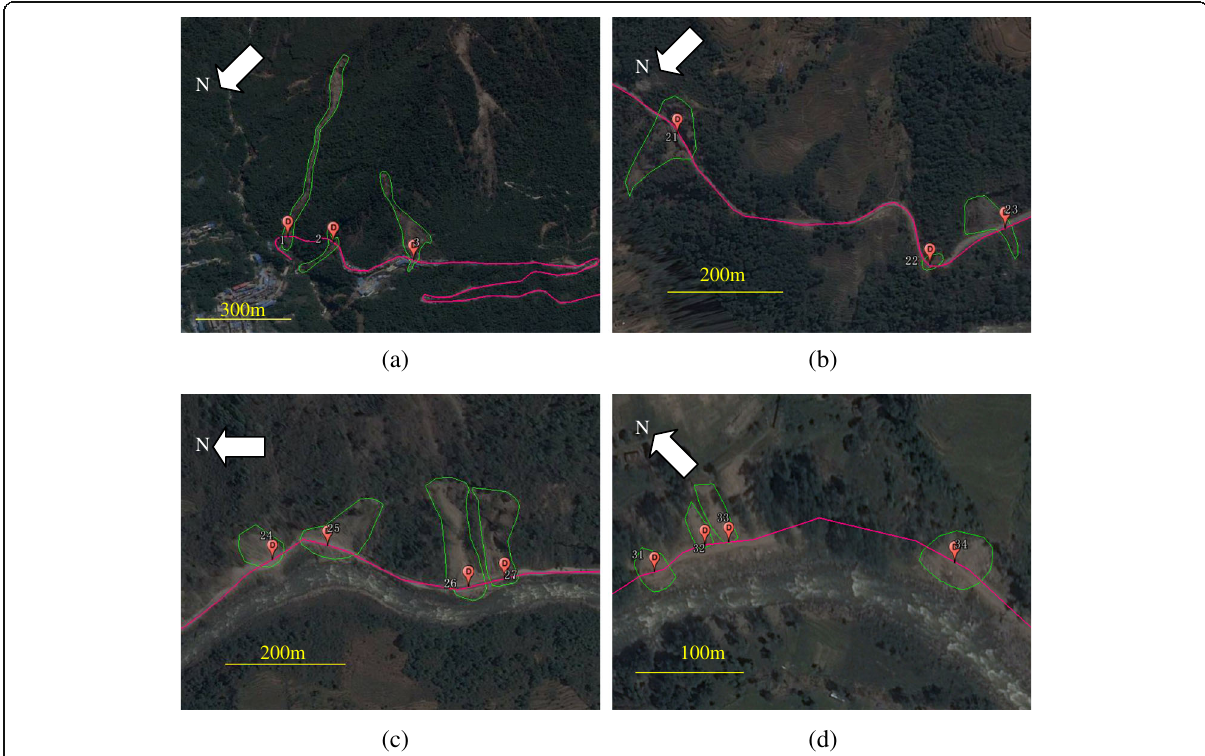
Fig. 7 Damaged sites along Araniko Highway by coseismic landslides have been seen on satellite images. The detailed information of the landslides and associated damages on the road is listed in Table 1. a the No. 1, 2, and 3 landslides, ( b ) the No. 21, 22, and 23 landslides, ( c ) the No. 24, 25, 26, and 27 landslides, and ( d ) the No. 31, 32, 33, and 34 landslides along Araniko Highway. All the satellite images were acquired on 4 May, 2015